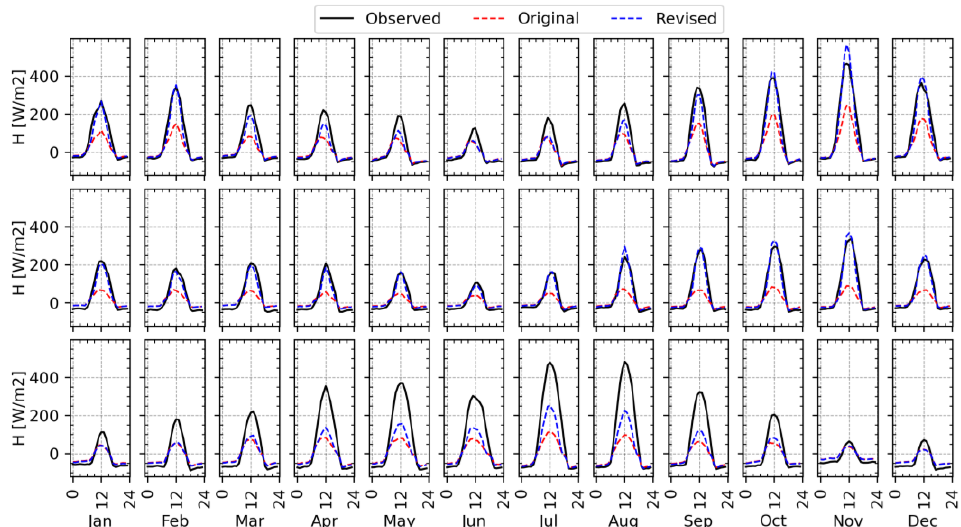
Figure 7. Time-averaged diurnal variations in the observed and simulated sensible heat flux by the original and the revised parameterization at Evergreen Broadleaf Forest (EBF) sites. The top row corresponds to the Cumberland Plain site in Australia (AU-Cum), the middle row to the Robson Creek site in Australia (AU-Rob), and the bottom row to the Puechabon site in France (FR-Pue).